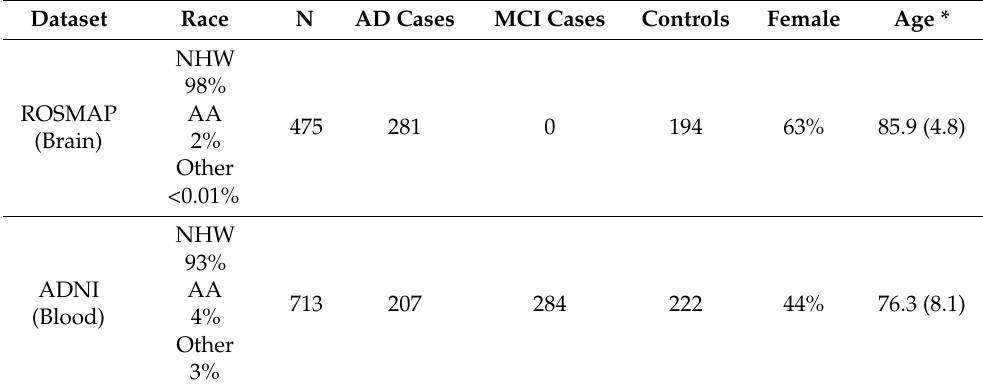
Table 1. Characteristics of subjects in the Religious Orders Study/Memory and Aging Project (ROSMAP) and Alzheimer’s Disease Neuroimaging Initiative (ADNI)